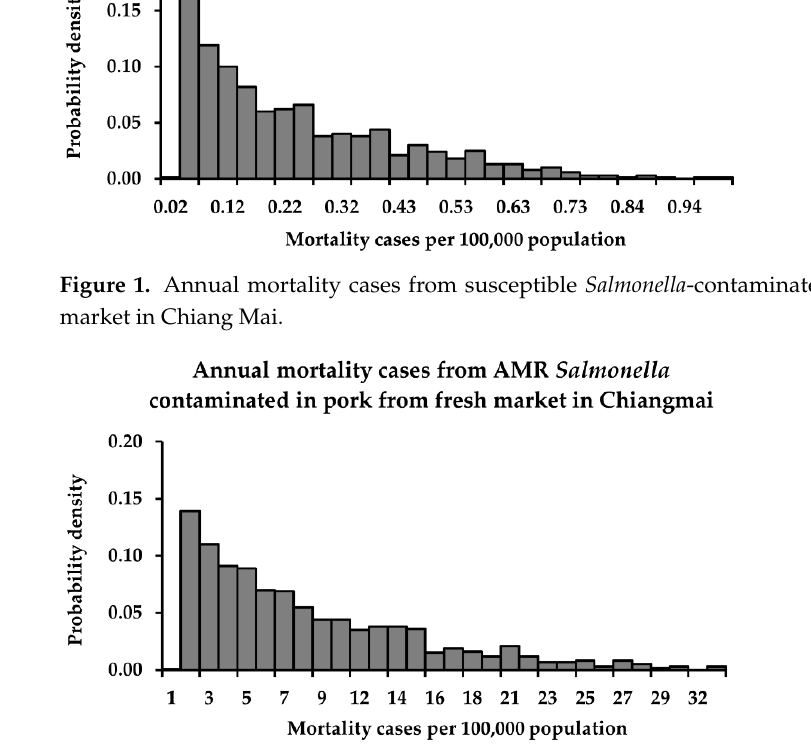
Figure 2. Annual mortality cases from QR Salmonella -contaminated pork from the fresh market in Chiang Mai.